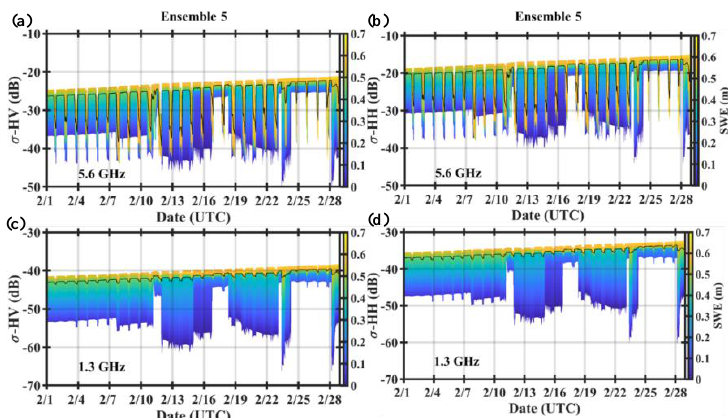
Figure 10. Temporal evolution of ensemble backscattering coefficient σ-HH and σ-HV at 5.6 GHz ( a, b ) and 1.3 GHz ( c, d ) contoured by Ensemble 5 SWE. The black line is the Ensemble 5 mean. Note the diurnal cycle of the sensitivity of the ensemble mean that it is dominant at 5.6 GHz, including for high SWE ensemble members.